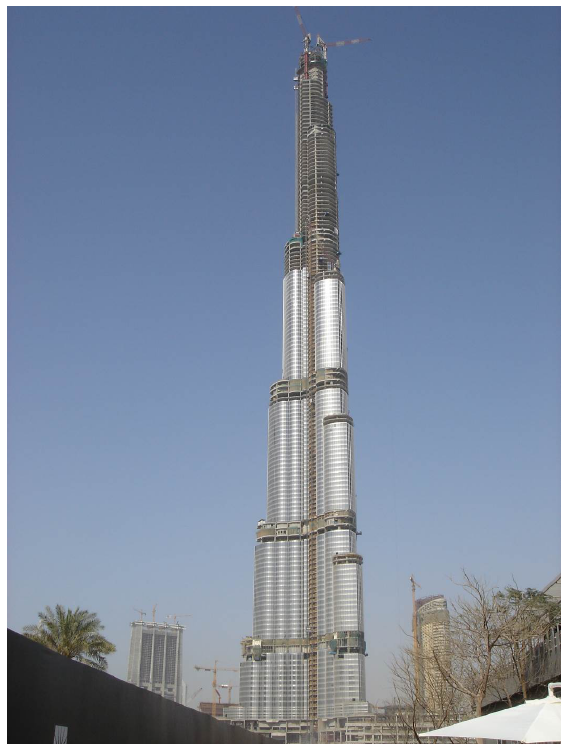
Figure 4. Burj Khalifa (photo by Kyoung Sun